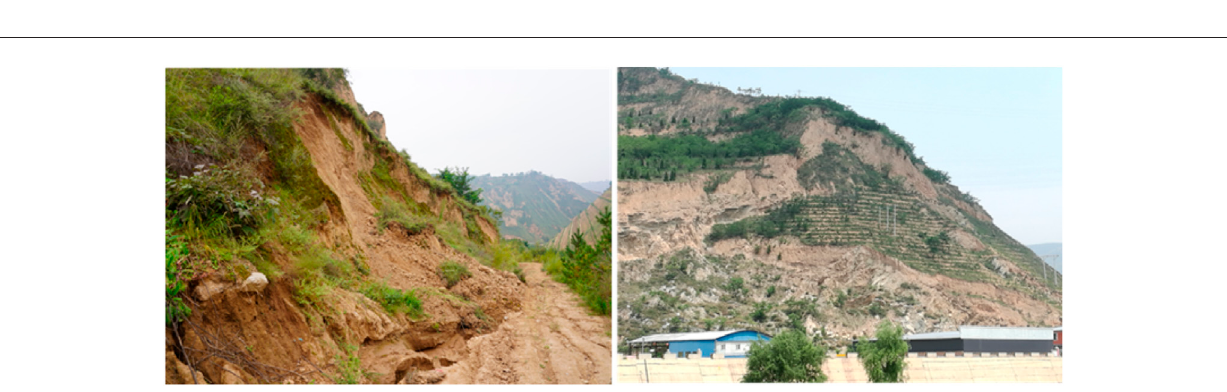
FIGURE 1 | The study area and spatial distribution of the